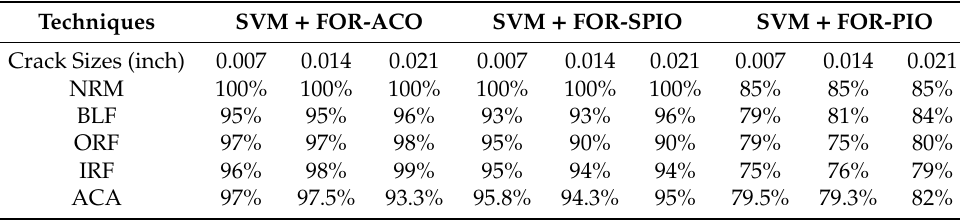
Table 7. The Accuracy of Single-Type Fault Identification When the Torque Load is